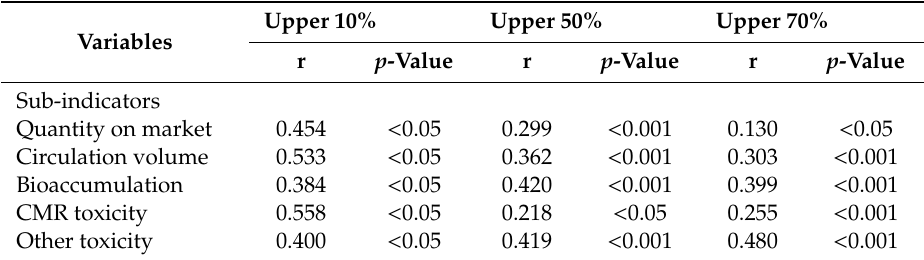
Table 7. Correlation coe ffi cients (r) from linear regression analysis for the e ff ect of sub-indicators on total score according to the top rank